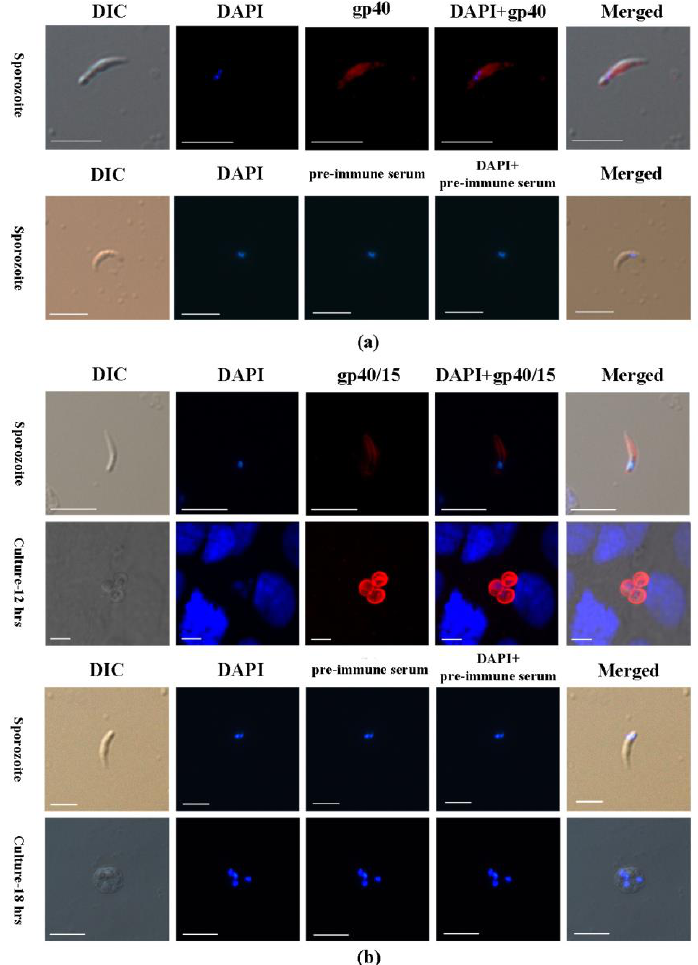
Figure 3. Immunofluorescence microscopic detection of Cpgp40 / 15 and Cpgp40 in di ff erent C. parvum life cycle stages. ( a ) Distribution of Cpgp40 in the sporozoites using the rabbit anti-Cpgp40 antibody and pre-immune serum. ( b ) Association of Cpgp40 / 15 with the parasitophorous vacuole membrane (PVM) during the parasite intracellular developmental stages, including early and mature meronts, using rabbit anti-Cpgp40 / 15 antibody and pre-immune serum. Images were taken by di ff erential interference contrast microscopy (DIC), fluorescence microscopy using nuclear stain 4,6-diamidino-2-phenylindole (DAPI); Scale-bars: 5 µ